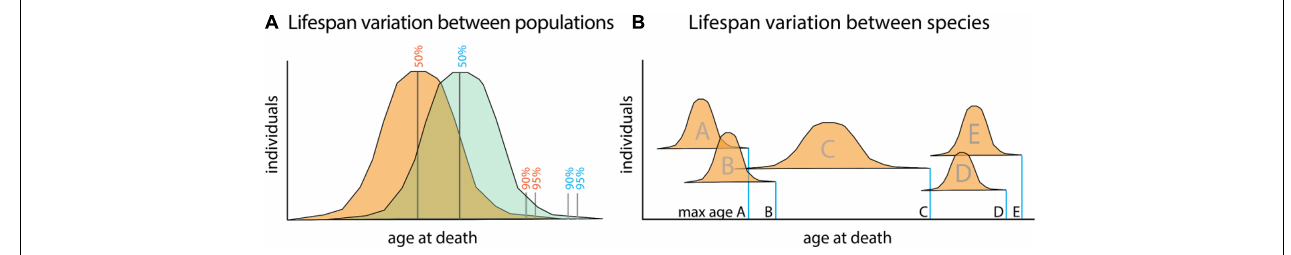
FIGURE 1 | Relationship between aging and lifespan variation versus species defining lifespan. (A) Lifespan comparisons within species, measured as mean (50%) or portion of a population living till extended limits of lifespan (90–95%). Differences between populations (orange and green) can identify specific genetic or environmental changes associating with long life. These factors promote viability and often associate with increasing healthspan. Mutant analysis within a particular model organism often encompasses these types of changes as it relates to lifespan. (B) Maximum lifespans recorded for different species (A–E). While lifespan variation within a species is capped to a certain extent, variation between species can range dramatically. Changes to maximum lifespan often are associated with protective mechanisms for genomic and genetic fidelity as well as life history changes as they relate to maturation and